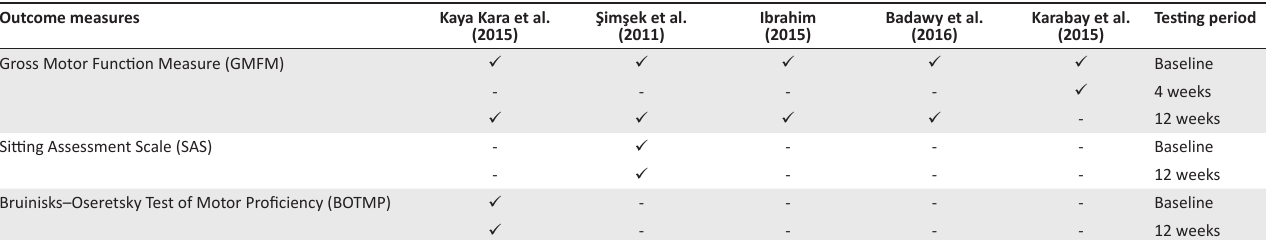
TABLE 4: Timeline and outcome measures used by included studies. Outcome measures